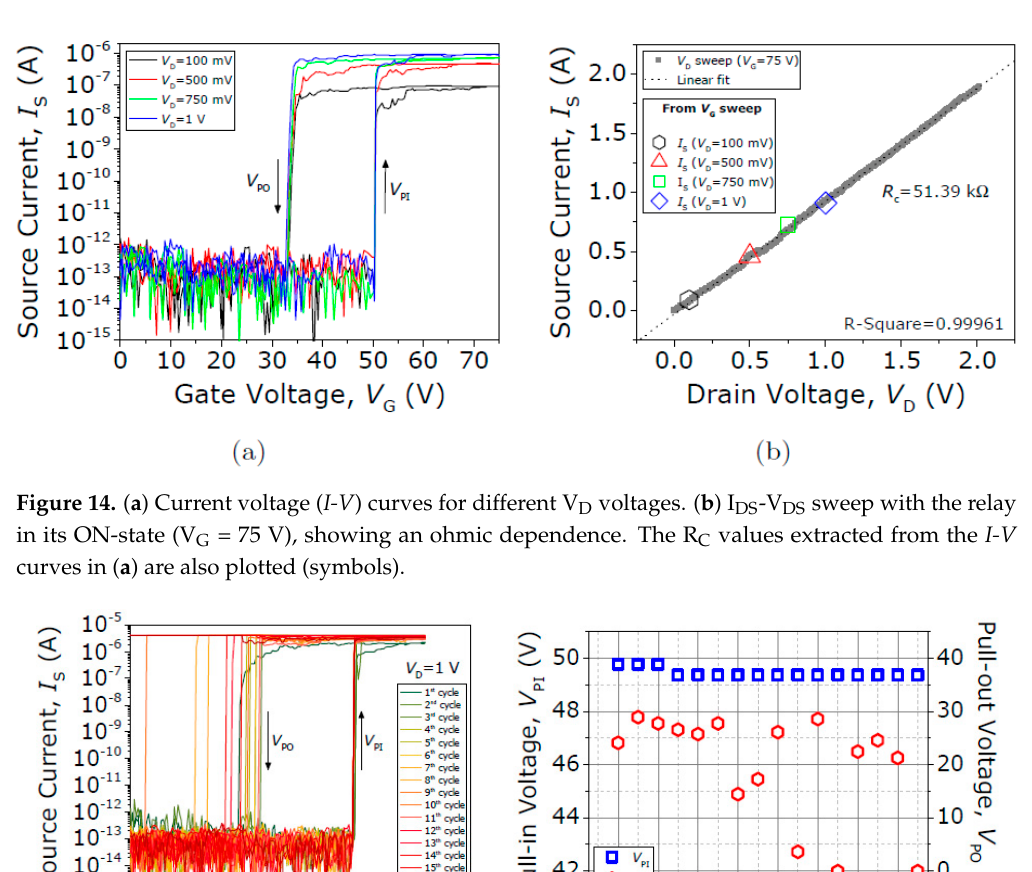
Figure 14. ( a ) Current voltage ( I-V ) curves for different V D voltages. ( b ) I DS -V DS sweep with the relay in its ON-state (V G = 75 V), showing an ohmic dependence. The R C values extracted from the I-V curves in ( a ) are also plotted (symbols).